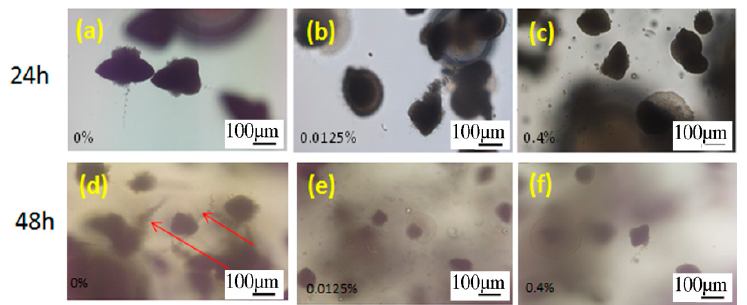
Figure 5. Optical micrographs of the C. albicans cells after 24 h ( a , b , c ) and 48 h ( d , e , f ) of incubation, embedded in agar without oleic acid (OA), (control, 0% OA, a , d ), with 0.0125% OA ( b , e ) and 0.4% OA ( c , f ). Arrows mark spindle-shaped colonies with sporadic hyphae and/or pseudohyphae on the margins and lateral yeasts after 48 h incubation .